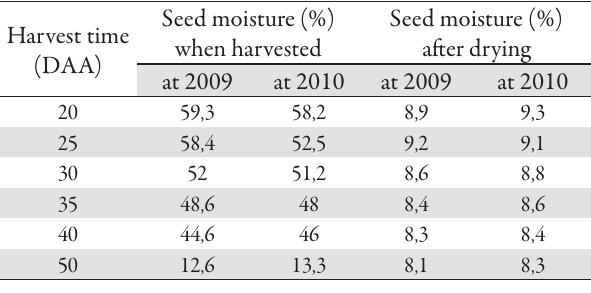
Tab. 2. Effects of different harvesting times on seed moisture